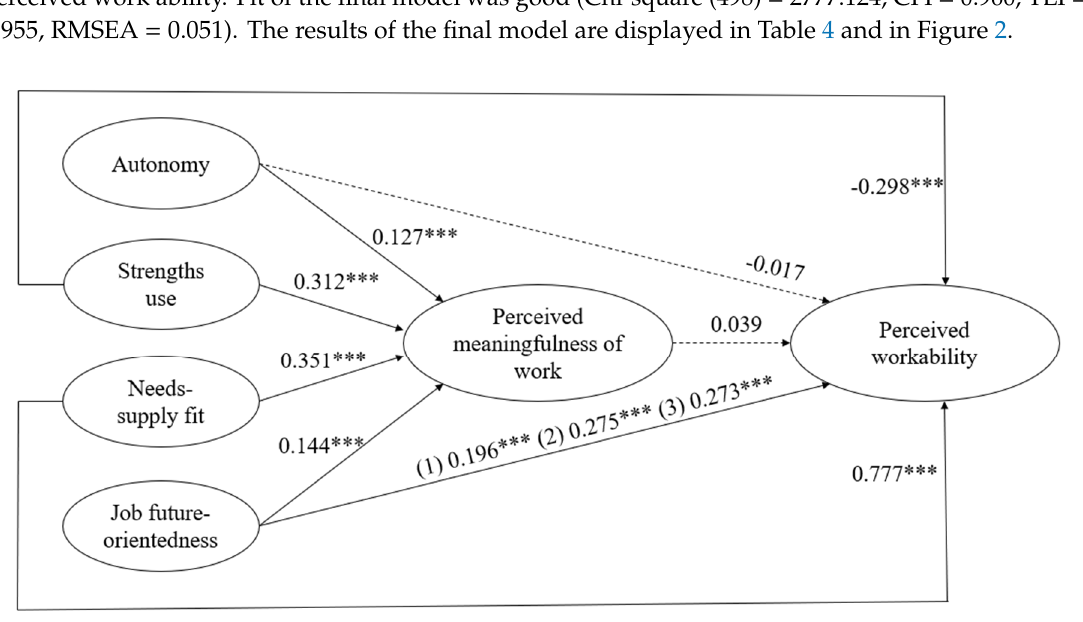
Figure 2. Final model. Note: *** p < 0.001. When bèta-weights are the same for the three age categories, only one value is reported (1) = age 20–34; (2) = age 35–49; (3) = age 50+; Fit indices final model: Chi-square (498) = 2777.124, CFI = 0.960, TLI = 0.955, RMSEA = 0.051; Dotted lines represent non-significant relationships.